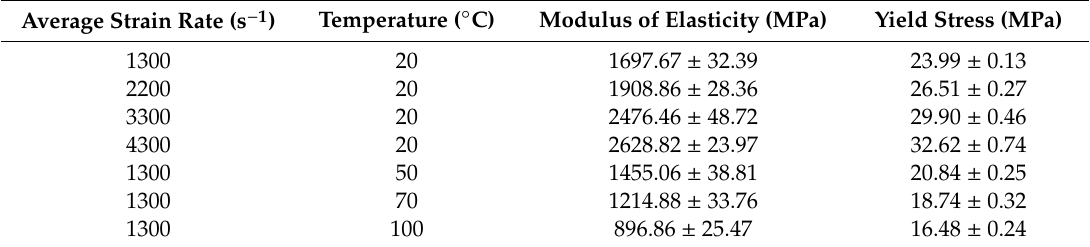
Figure 4. Stress–strain curves of UHMWPE at a temperature of 20 °C and strain rates of 1300–4300 s − 1. Table 4. Compressive properties of UHMWPE.